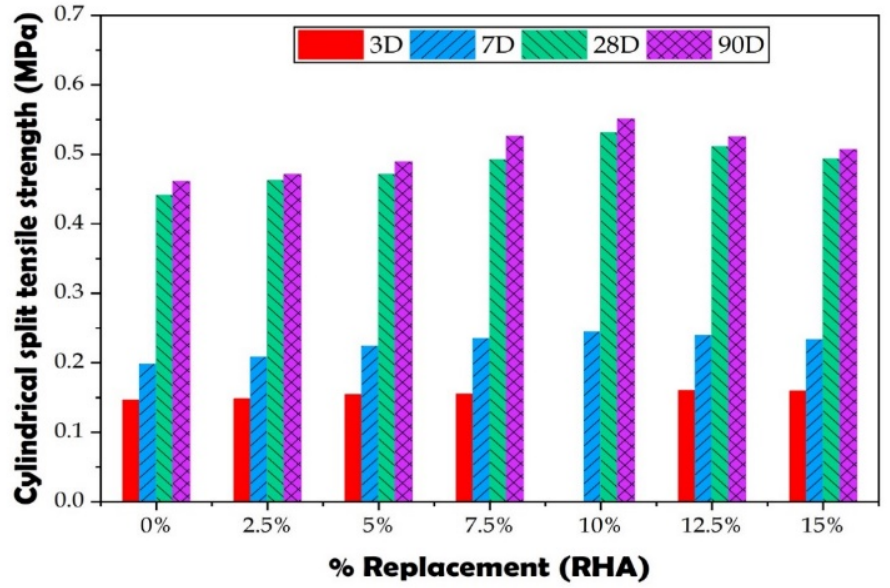
Figure 8. Split Tensile Strength of aerated concrete (D—days).